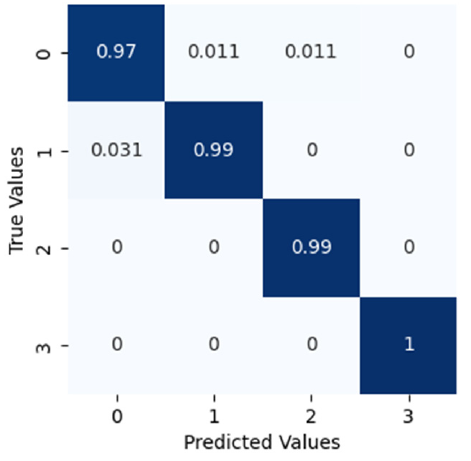
Figure 13. The confusion matrix for this classification.